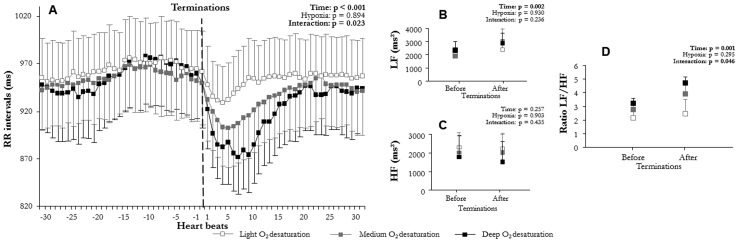
Comparison of autonomic modulation at apnea/hypopnea terminations according to oxygen desaturation: (A) RR intervals (RR), (B) low (LFWV) and (C) high frequency (HFWV) wavelet power, and (D) LFWV/HFWV ratio before and after apnea/hypopnea terminations according to light oxygen desaturation (min SaO2≥90%) medium (90>min SaO2>85%) and deep oxygen desaturation (min SaO2≤85%) (mean ± SEM).An overall effect on RR intervals, LFWV, and LFWV/HFWV ratio appeared between before and after apnea/hypopnea terminations. Apneas/hypopneas induced a sympathetic-dependent RR decrease, which was higher when apneas/hypopneas produced deep oxygen desaturation.